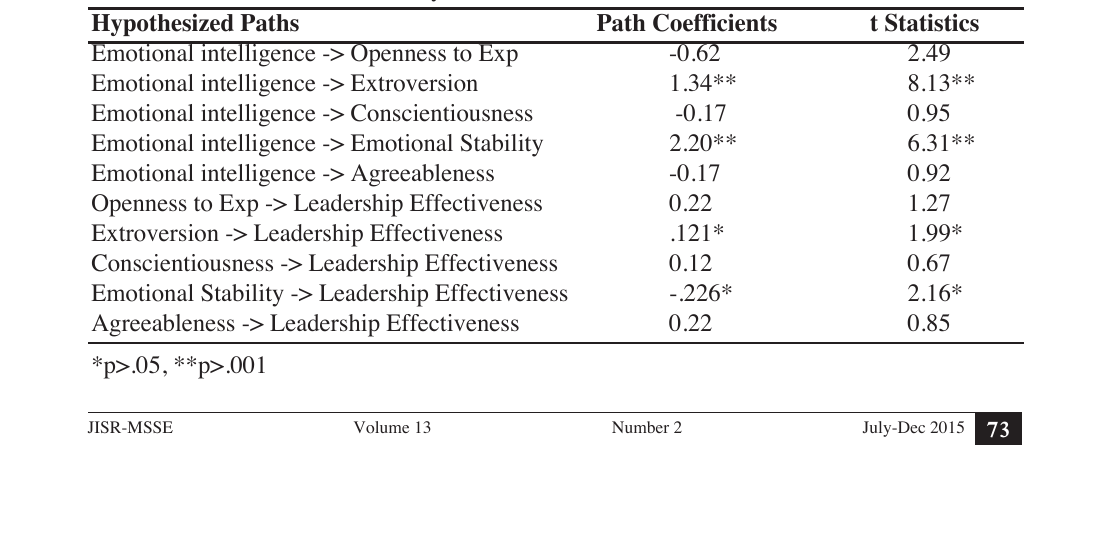
Table 2: Standardized Coefficients and t-values from Path analysis of the